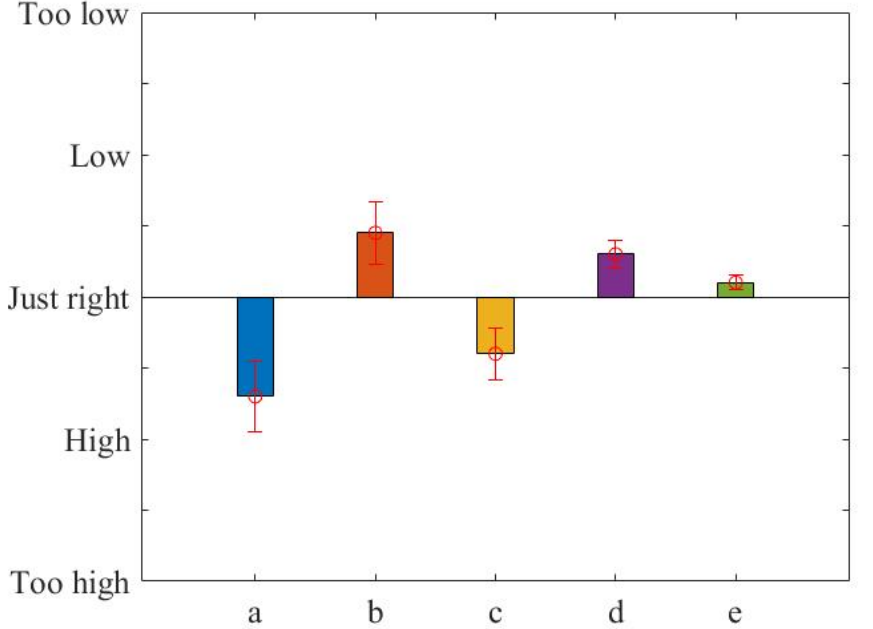
Figure 9. Qualitative analysis result of noise, showing the average ratings from the conducted experiment, with error bars for the standard errors. ( a ) KPN [3]. ( b ) CBDNet [24]. ( c ) SRNet [14]. ( d ) WCNN [13]. ( e ) Ours.